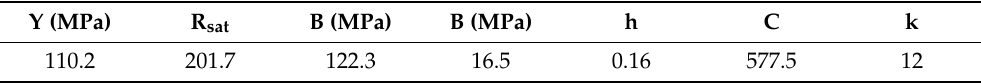
Table 2. Yoshida – Uemori hardening parameters for SA5182 (AA5182-O) [24].